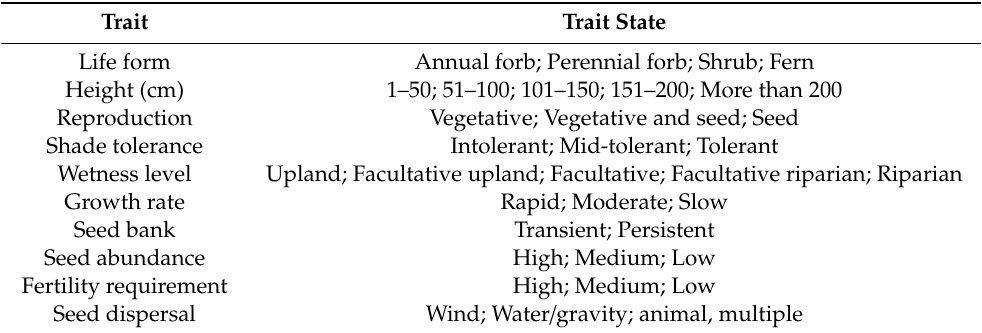
Table 2. Ten trait groups and trait states use in the trait matrix. The sources of literature were listed in Supplementary